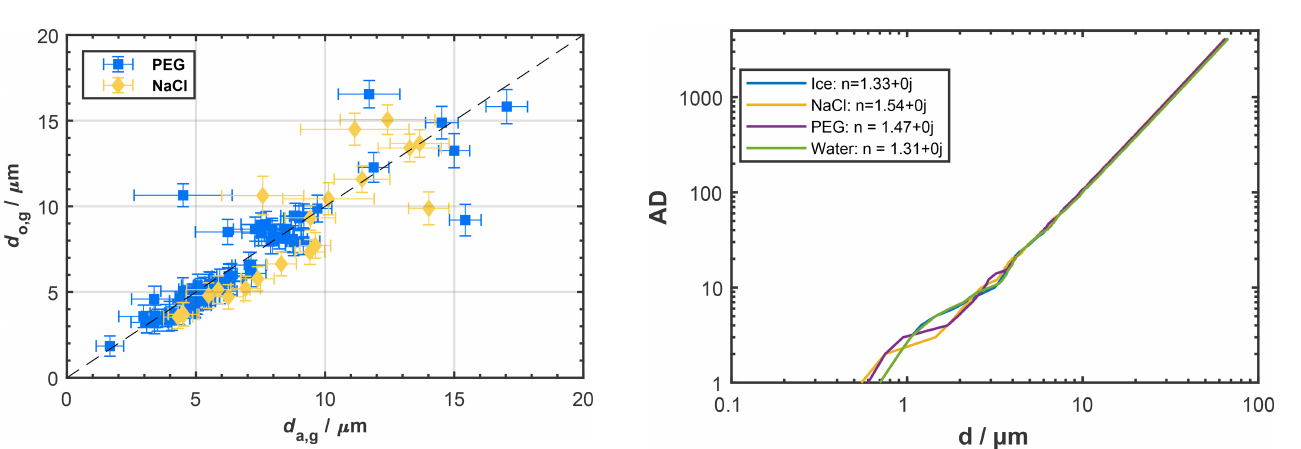
Figure 5. PPD-HS instrument response (AD) as a function of parti- cle diameter for different particle types measured in this study. AD is a function of the particle scattering cross section and instrument properties such as photodiode sensitivity, signal amplification and laser power (see Supplement Sect.